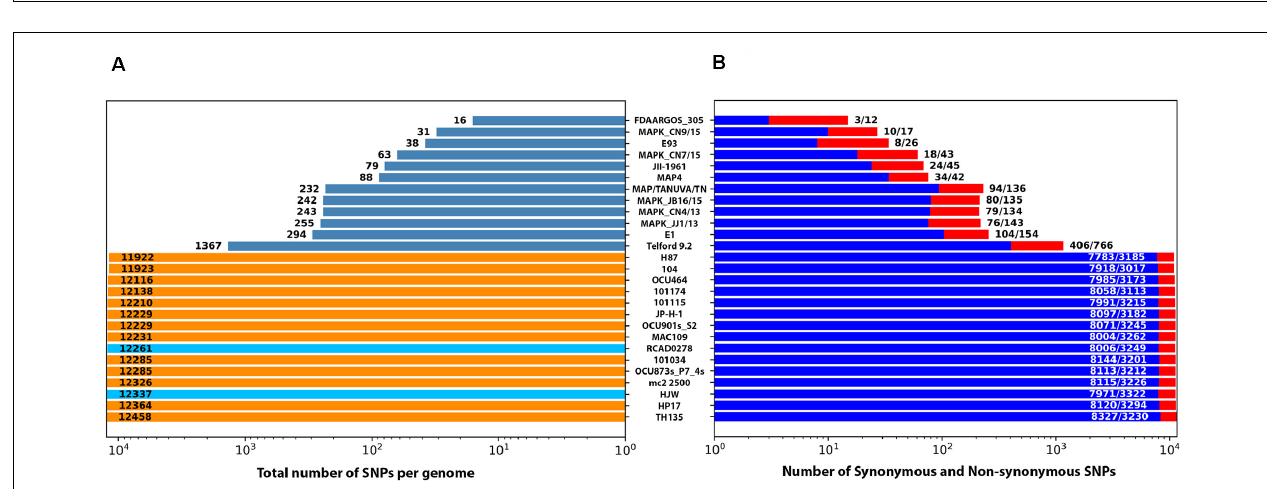
FIGURE 1 | Nucleotide level similarity analysis. The top matrix shows the Jaccard pairwise cluster similarity and the bottom matrix show the average nucleotide identity (ANI). The ANI values are a similarity index between two genomes expressed as a percentage. Jaccard percentages were obtained by direct pairwise genome comparisons using PanOCT as described in the methods. Note that the Jaccard similarity has a much broader range of values. The strain names and corresponding RefSeq accession numbers are shown in both matrices. Heat map shows high similarity in red versus lower values in green.